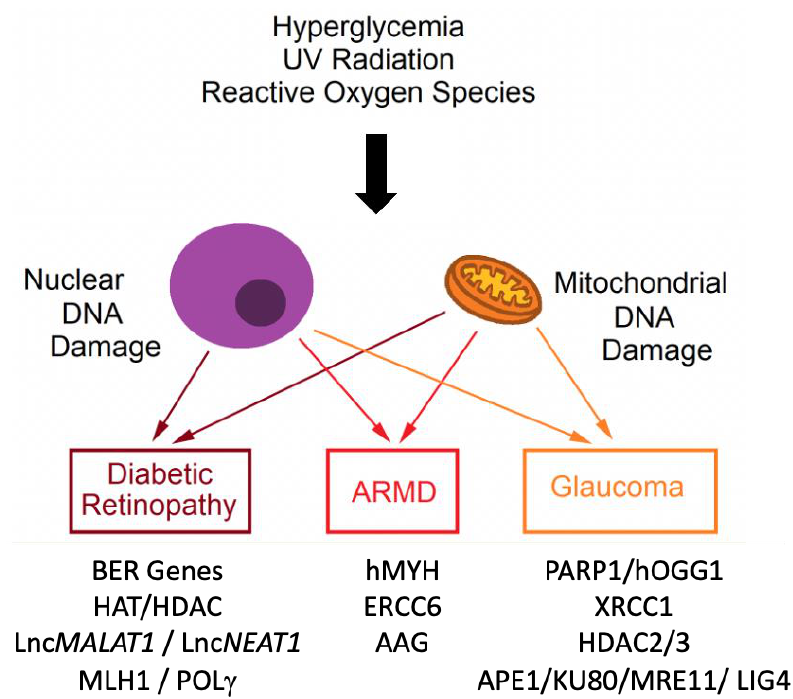
Figure 2. Hyperglycemia, ultraviolet radiation, and reactive oxygen species affect the development of glaucoma, DR, and ARMD (ARMD) via induction of mitochondrial and nuclear DNA damage. The list of DNA repair genes and pathways altered in each eye disease is shown as the molecular targets for therapy.